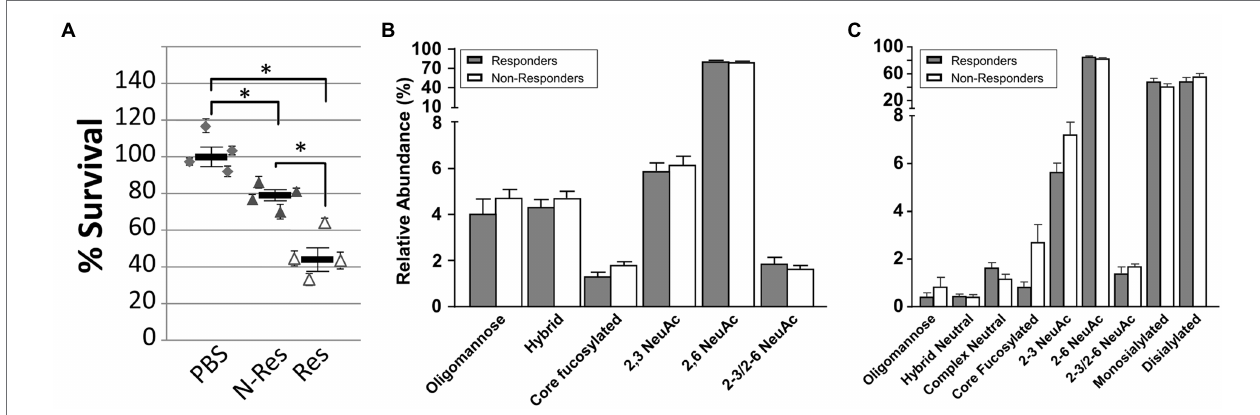
FIGURE 3 | Antibody characterization in sera from responder and non-responder birds. (A) Opsonophagocytosis (OPA) assay. All sera (from Experiment A, B, and C) from negative control (PBS), responder (Res) and non-responder (N-Res) birds, collected on day 27 were pooled and evaluated for their ability to induce killing of Campylobacter by opsonophagocytosis. Each data point represents an independent replicate (each with fresh individually grown Campylobacter cells and individual blood samples from 35-day-old naïve broiler birds that served as a source for white blood cells). Each assay was carried out in triplicate, variations are shown by error bars. The bar represents the average for the four independent assays, error bars depict the standard error of the mean (SEM). Survival is expressed as percentage CFU compared to pooled sera from the negative control group (set to 100%). Statistically significant differences (two-tailed t -test, p < 0.05) are indicated by an asterisk. (B) Distribution of N-glycans in total chicken serum analyzed by PGC LC ESI MS/MS. Individual N-glycans as identified from 10 individual responders and five non-responder birds have been summed according to groups representative for biosynthetic features (e.g., core-fucosylation = FUT8 activity, sialic acid linkage type, and structure class). (C) Distribution of N-glycans in enriched chicken IgY analyzed by PGC LC ESI MS/MS. Purified total IgYs from of four individual responders and five non-responder birds were analyzed. Statistical significance was calculated using two-way ANOVA wherein the value of p was ≤